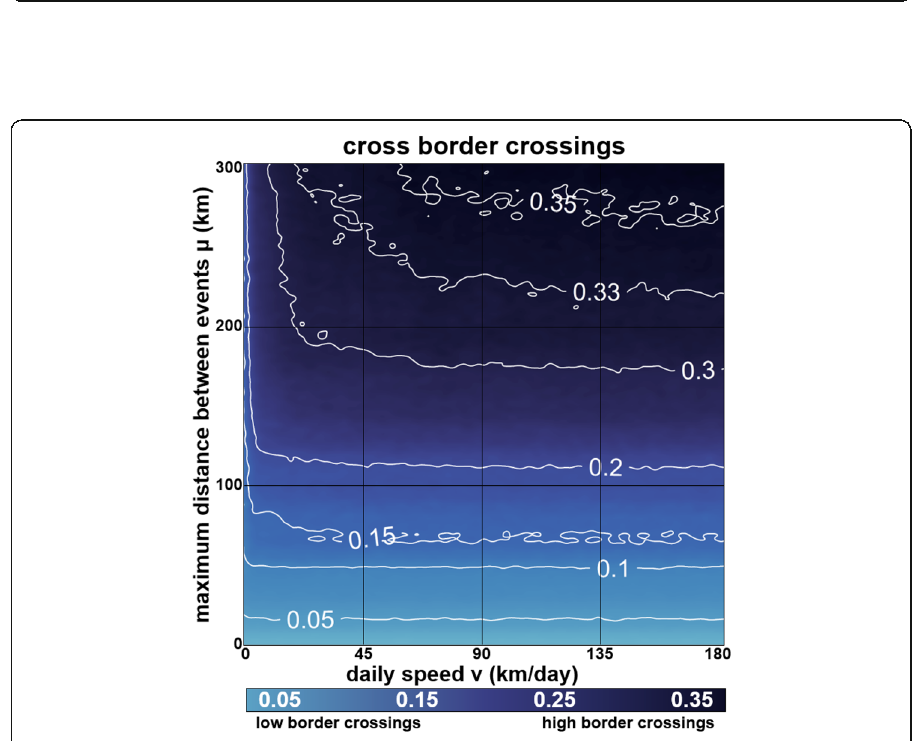
Fig. 8 The fraction of times that a cell crosses an international border depending on daily speed ν , and the distance between two events μ . With a speed of ν = 60 kilometres and a maximum distance of μ = 180 kilometres, Boko Haram cells cross a border 30% of the time between any two consecutive